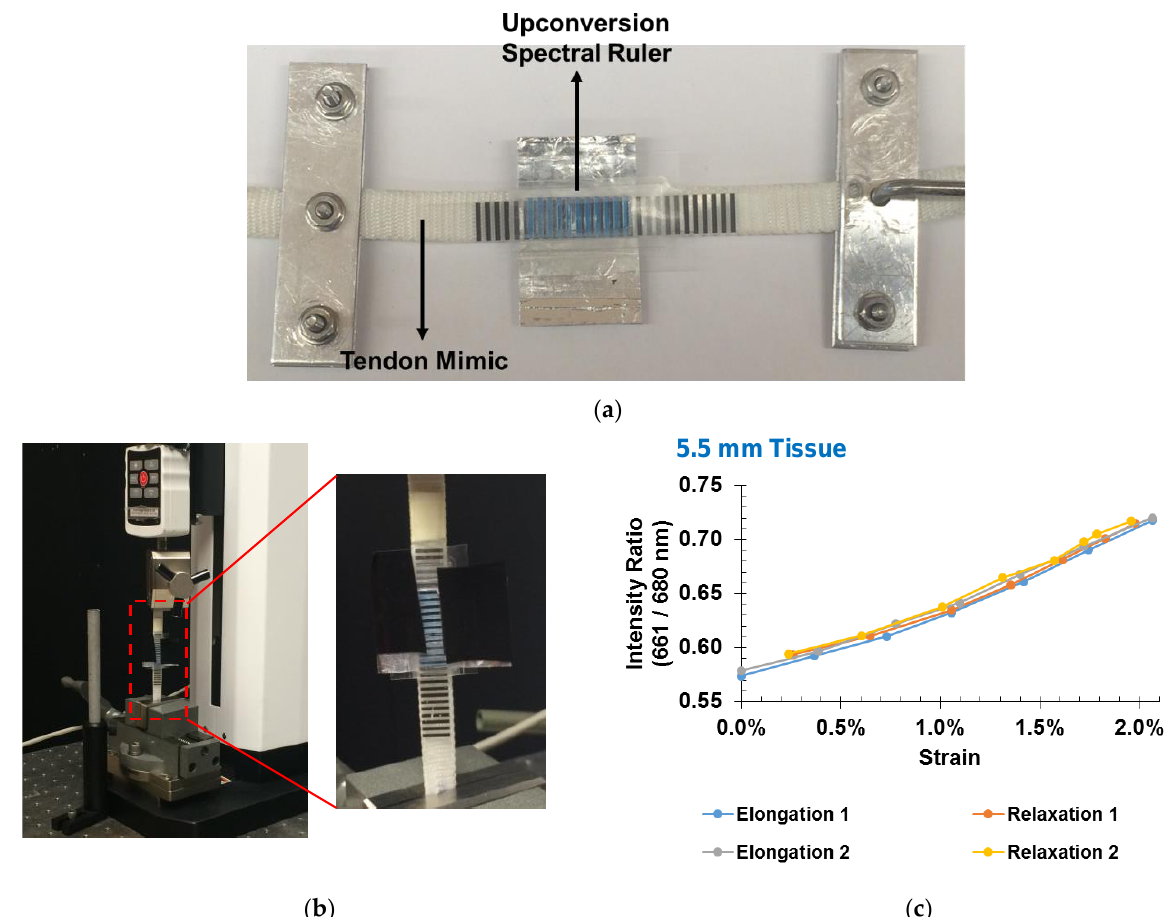
Figure 7. ( a ) Photograph of an upconversion spectral ruler attached to a 10 mm wide cruciate ligament mimic. ( b ) Photo of setup on Mark-10 test stand. ( c ) Spectral ratio vs. strain for load cycles, measured through 5.5 mm of chicken breast tissue. Each point represents 10 s of data (the average of 10 measurements with 0.1 s exposure each).